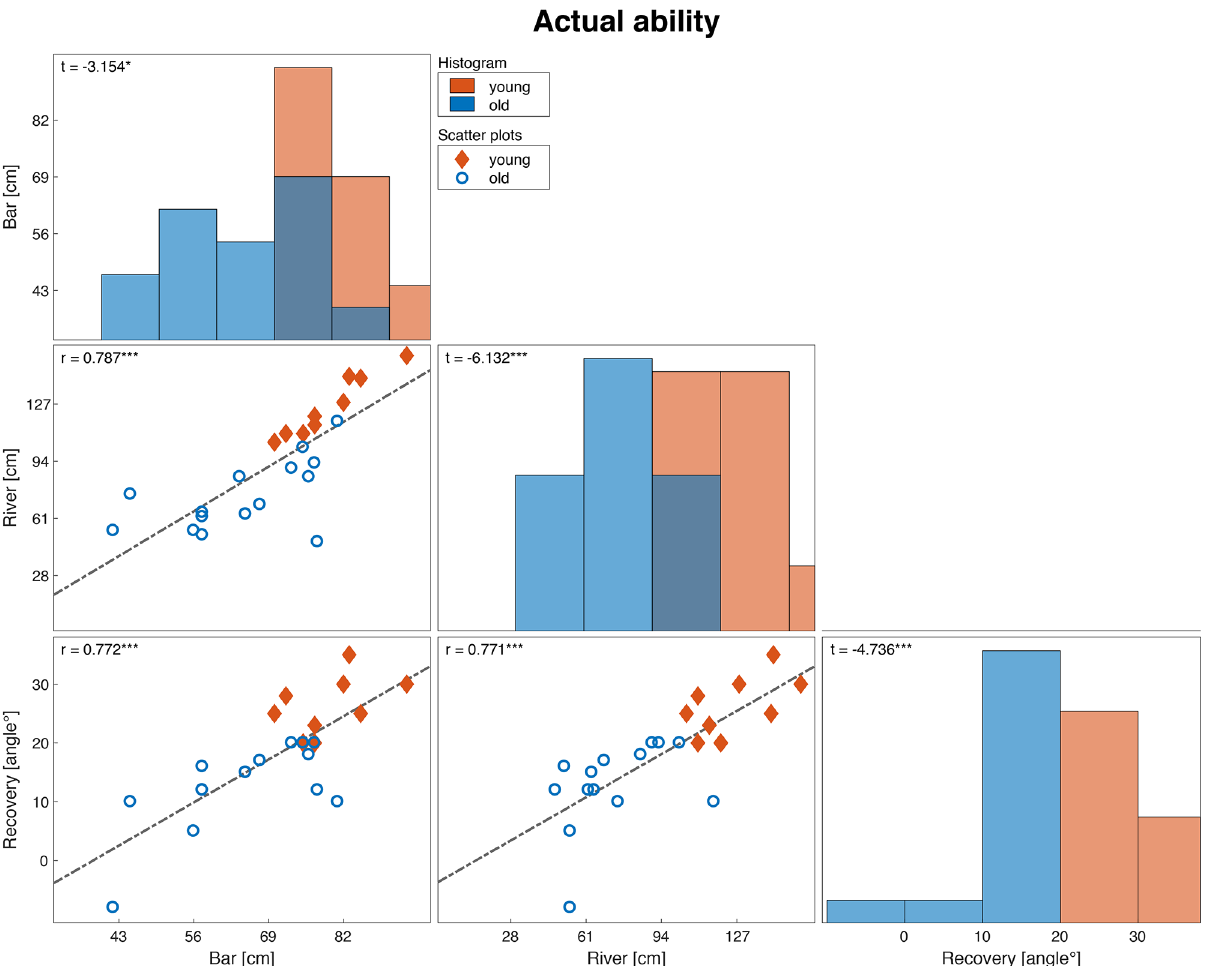
Fig 2. Distribution and correlation matrix of the actual ability measuresof the different tasks. The diagonalpanels(histograms) show the distributionof the three actual ability measures for the two age groups. The off-diagonalpanels (scatter plots) show correlations between actual physicalability measures of different tasks. Diamondsrepresentyoung adults and circles represent older adults. Corresponding correlationcoefficients and t-tests (i.e., testing the differencesbetween youngand older adults) are indicatedin the top-left corner of each panel ( * :p < 0.05, ** :p < 0.01, *** :p < 0.001). Note that the actual ability measure used for the ‘bar’ task was used for the actual ability measure for the ‘cord’ task.